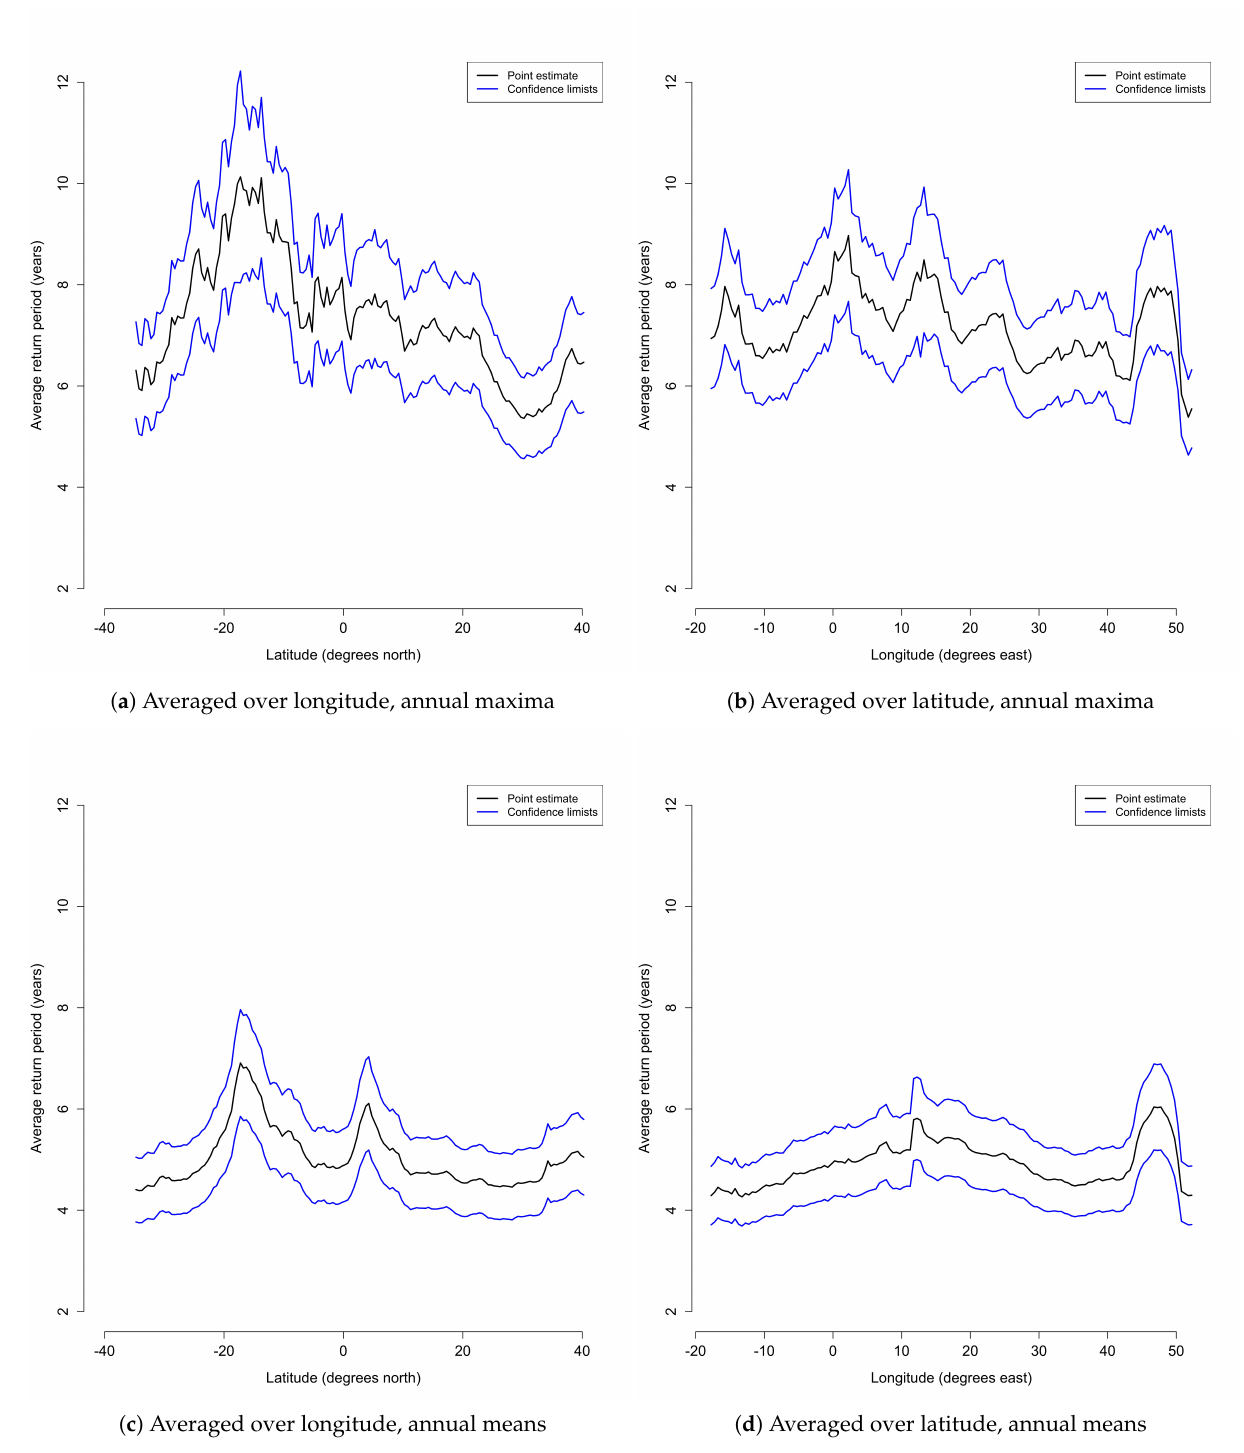
Figure 10. The latitude cross–section ( a , c ) and the longitude cross-section ( b , d ) of average return periods (ARP) of extremes based on ECDF 2 : ( a ) ARP of extremes in annual maximum temperatures, averaged over longitudes, ( b ) ARP of extremes in annual maximum temperatures, averaged over latitudes, ( c ) ARP of extremes in annual mean temperatures, averaged over longitudes and ( d ) ARP of extremes in annual mean temperatures, averaged over latitudes. The two blue curves represent the lower and upper confidence limits of the 95% confidence interval and the black curve represents point estimate of